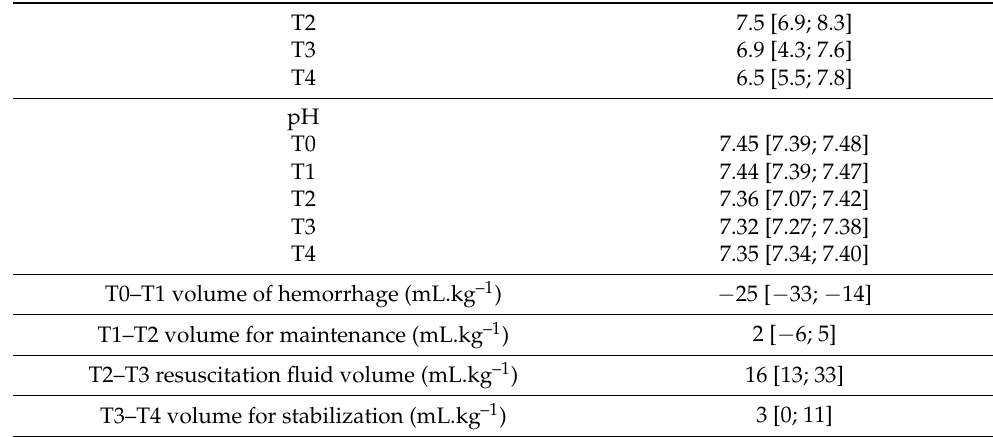
Figure 3. Variations of CO (L.min − 1 ) during the experiment. ( A ) CO as measured by thermodilution (COth); ( B ) CO calculated by ultrasound device with a manually measured sub-aortic velocity time